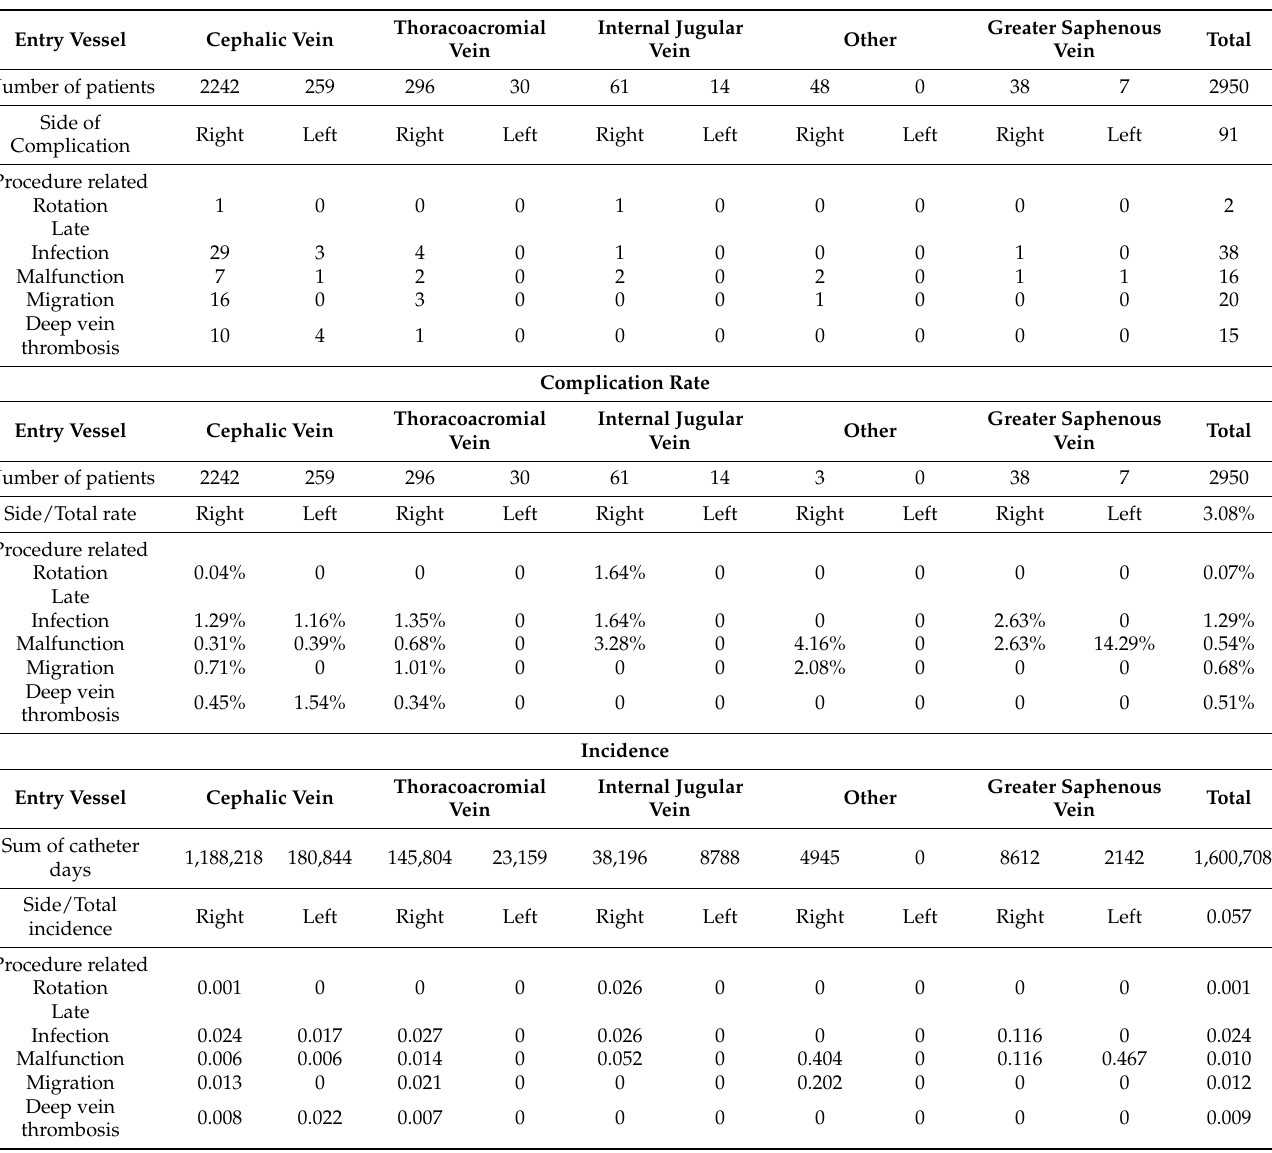
Table 2. Complication rate, incidence, and reason for re-intervention.